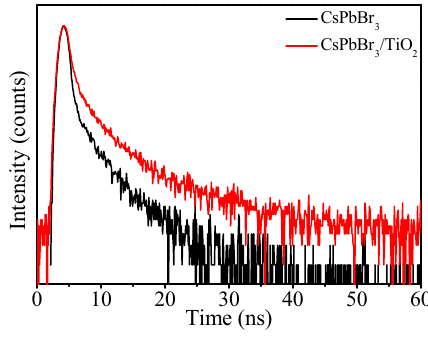
Fig. 8 Time-resolved PL decay curves obtained from CsPbBr CsPbBr /TiO 3 2